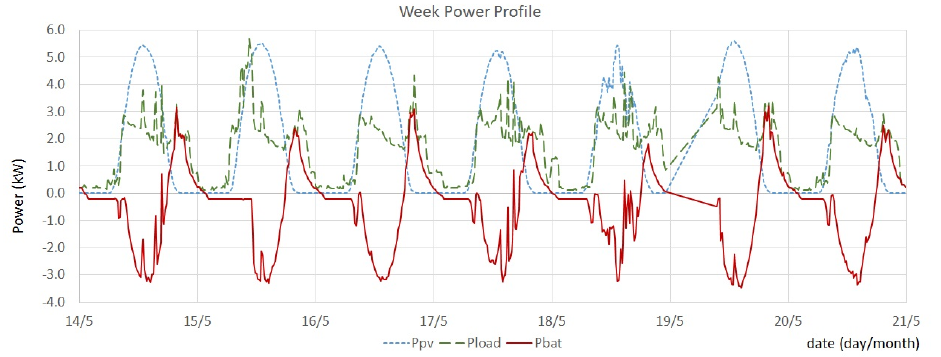
Figure 7. One week display of the PV, loads, and battery power profiles (P P V , P load , and P bat , respectively).